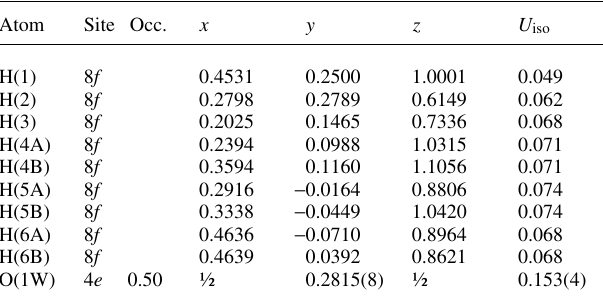
Table 2. Atomic coordinates and displacement parameters (in Å 2 )